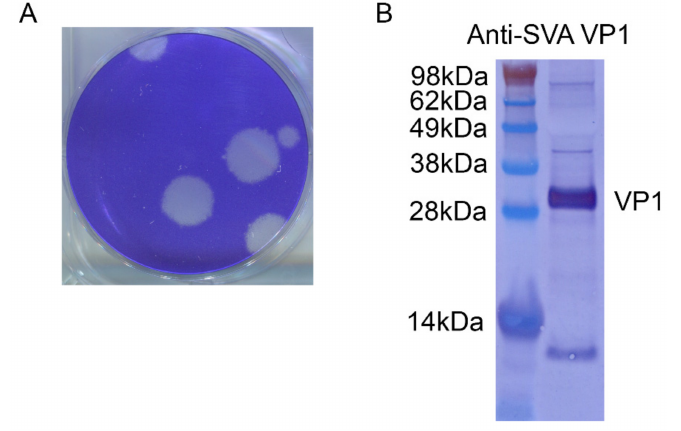
Figure 2. ( A ) Plaque-purified SVA produced 3 to 7 mm plaques on LF-BK α V β 6 cells after 48 h of incubation and ( B ) demonstrated strong reactivity to polyclonal anti-SVA VP1 antibody. Cultured SVA-LP8 was concentrated by PEG precipitation prior to application on a discontinuous CsCl gradients utilizing the same densities as for FMDV, 1.38 g/cm 3 and 1.42 g/cm 3 . Application of FMDV produced bands corresponding to infectious virus in the 1.42 g/cm 3 fraction and empty particles in the 1.38 g/cm 3 fraction, Figure 3A. SVA-LP8 produced a discrete band containing high titer infectious virus within the 1.38 g/cm 3 layer, similar to FMDV empty particles, Figure 3A, agreeing with a previously established density of 1.33 g/cm 3 [24]. The isolated CsCl band was characterized by both silver staining for total proteins and Western blotting for SVA VP1, Figure 3B, confirming the presence of antigen of appropriate size for SVA capsid proteins and specifically the presence of SVA VP1.